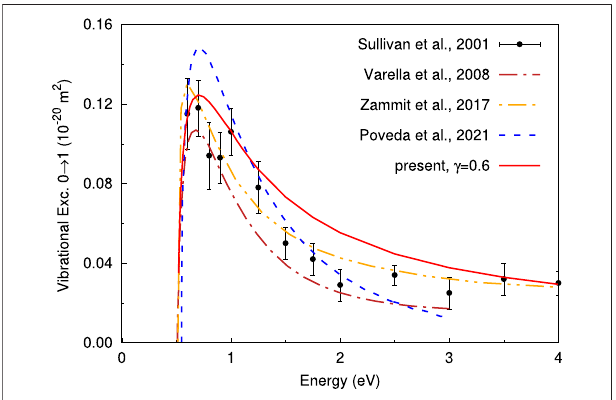
FIGURE 8 | (Color online) Comparison of the 0 → 1 vibrational excitation cross sections for H 2 . The present result correspond to a model potential with κ =1, ρ =1.85 and γ